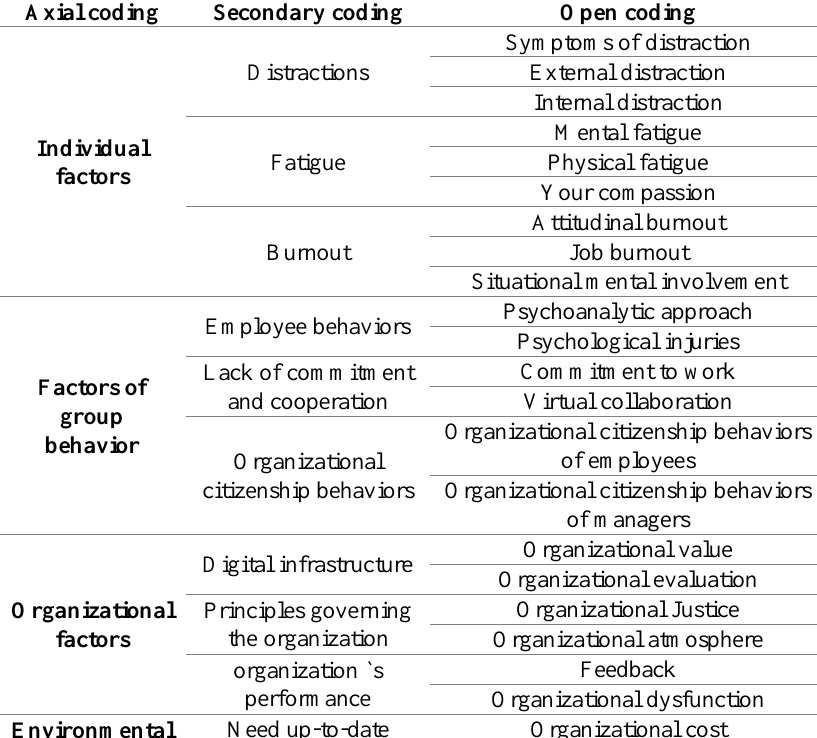
Table 2: Qualitative data coding (causal